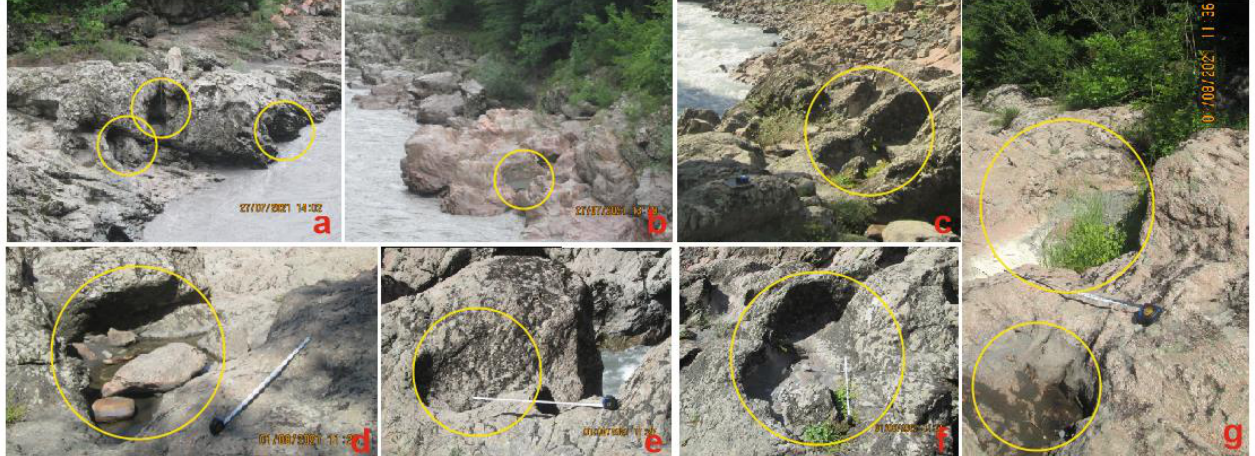
Figure 3. The relatively large pseudokarst features from the study plot and its vicinity: ( a – c ) partly submerged, near water level, and elevated potholes (the size of the shown plots is ~50 m 2 ), ( d – g ) morphological diversity of individual potholes (the tape indicates 1 m); yellow circles indicate the considered features.